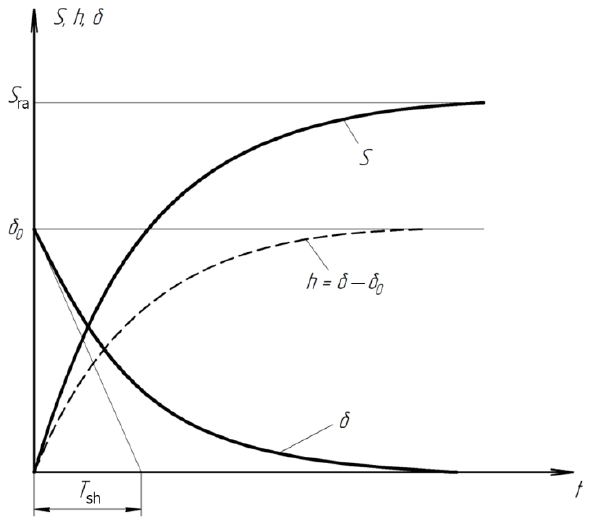
Figure 21. Time characteristics of the transient finishing process.